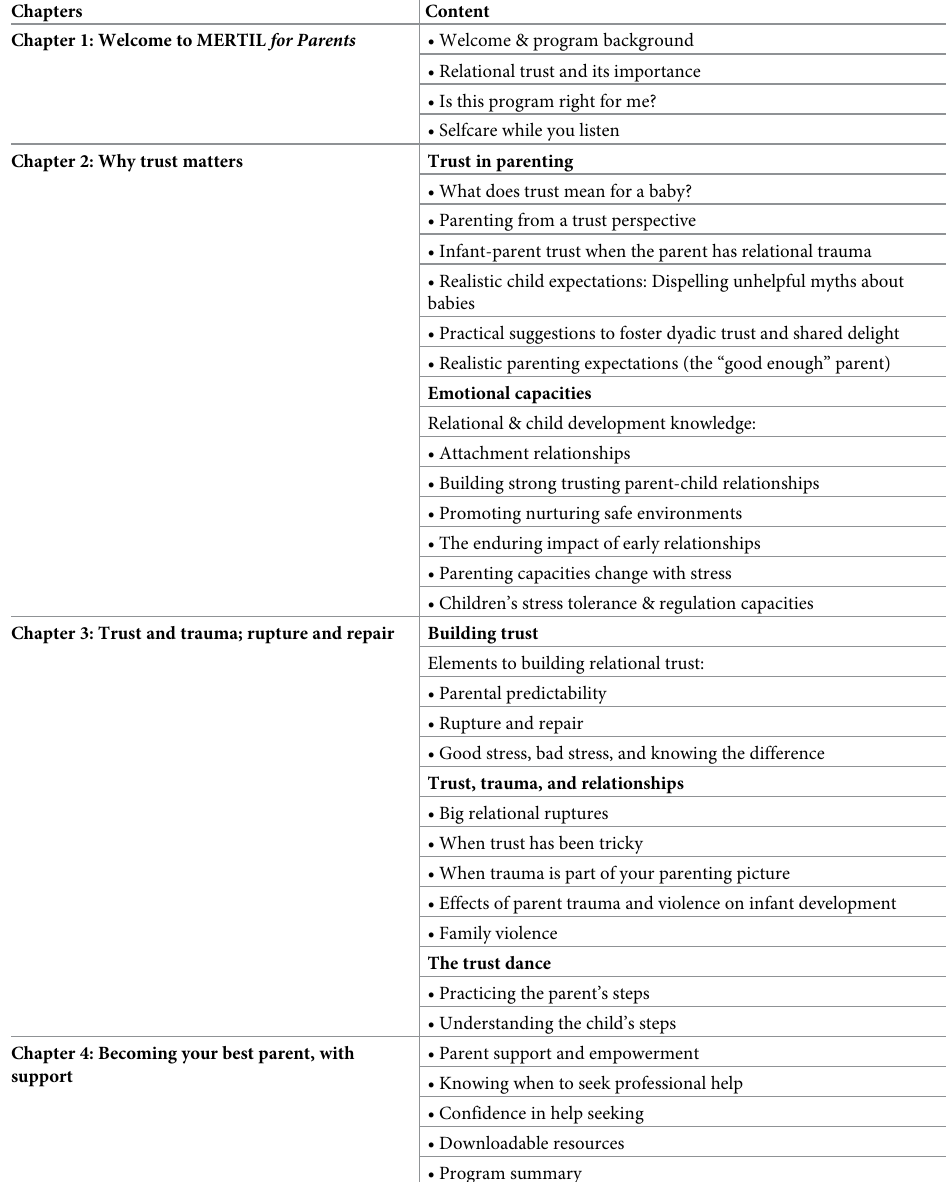
Table 1. MERTIL for Parents video